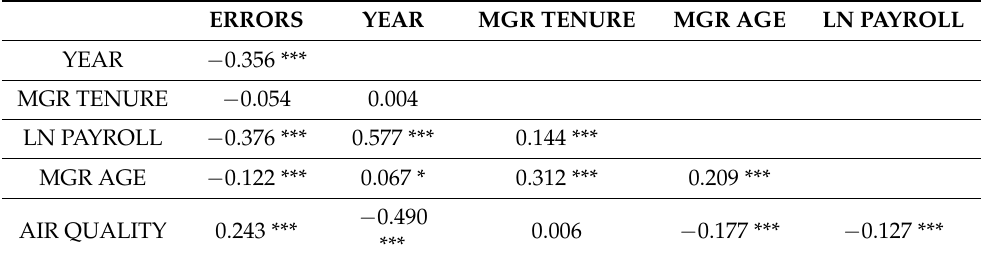
Table 2. Correlation matrix of regression variables for MLB sample.